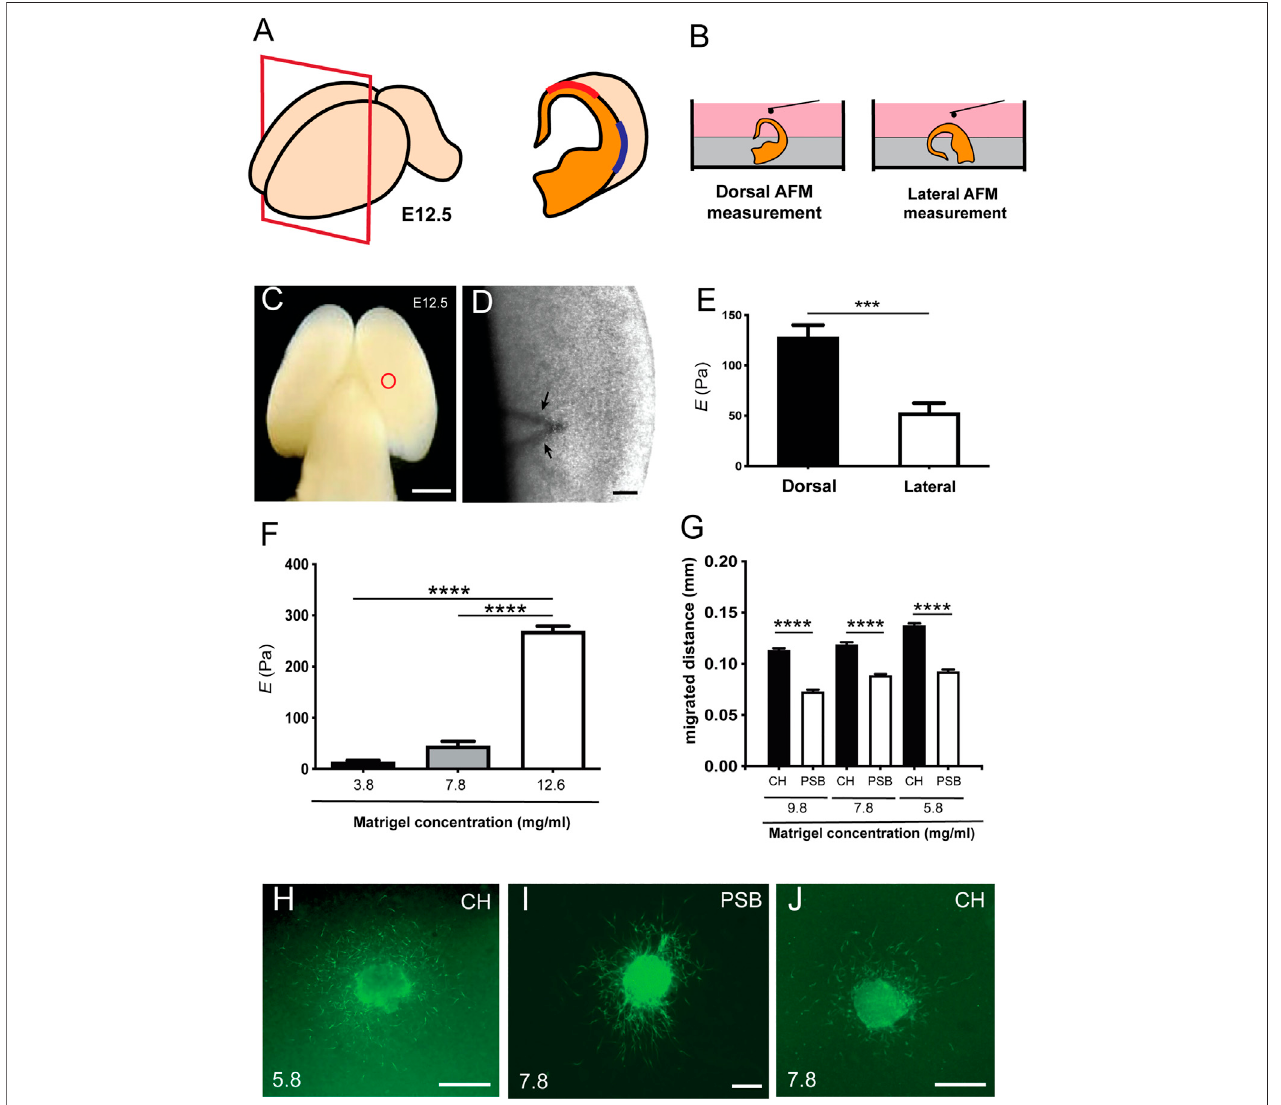
FIGURE1| Differentialstiffness between dorsal and lateral regionsofthe pallialmarginal zone indevelopingmouse embryos (A) Scheme illustrating the procedure ofplacementofthetelencephalichemispheresoftheembryo(E12.5). (B) IllustrationshowingtheprocedureforAtomicForceMicroscopy(AFM),inwhichthewholebrain embryowas fi rstembeddedinagarosetoobtaindorsalandlateralmeasurementusingtheBIO-AFM. (C,D) Scheme (C) andhighmagni fi cationphotograph (D) obtained from the BIO-AFM illustrating the location of the V-shaped cantilever (circle in C and arrows in D ) in the surface of the marginal zone. (E) Histogram showing the results of the BIO-AFM experiments; E values are displayed in the y axis in Pa. (F) Rheometric values obtained after the analysis of three different hydrogels. The concentration of the total protein of the analyzed hydrogels isshown in the x axis. (G) Bar plots comparing the amount of differential migration of CR cells (obtained from CH or PSB) for gradually higher Matrigel ™ concentrations (H – J) Examples of CH (H – J) and PSB (I) cultured explants in different Matrigel ™ concentrations (5.8 and 7.8 mg/ml) immunostained against CALR to identify CR cells. CH: cortical hem; PSB: pallium subpallium boundary. Data in (E,F,G) are presented as mean ± s.e.m.; *** p < 0.001 and **** p < 0.0001. Scale bars: C = 1 mm, D = 500 μ m, H and J = 300 μ m and I = 300 μ m.